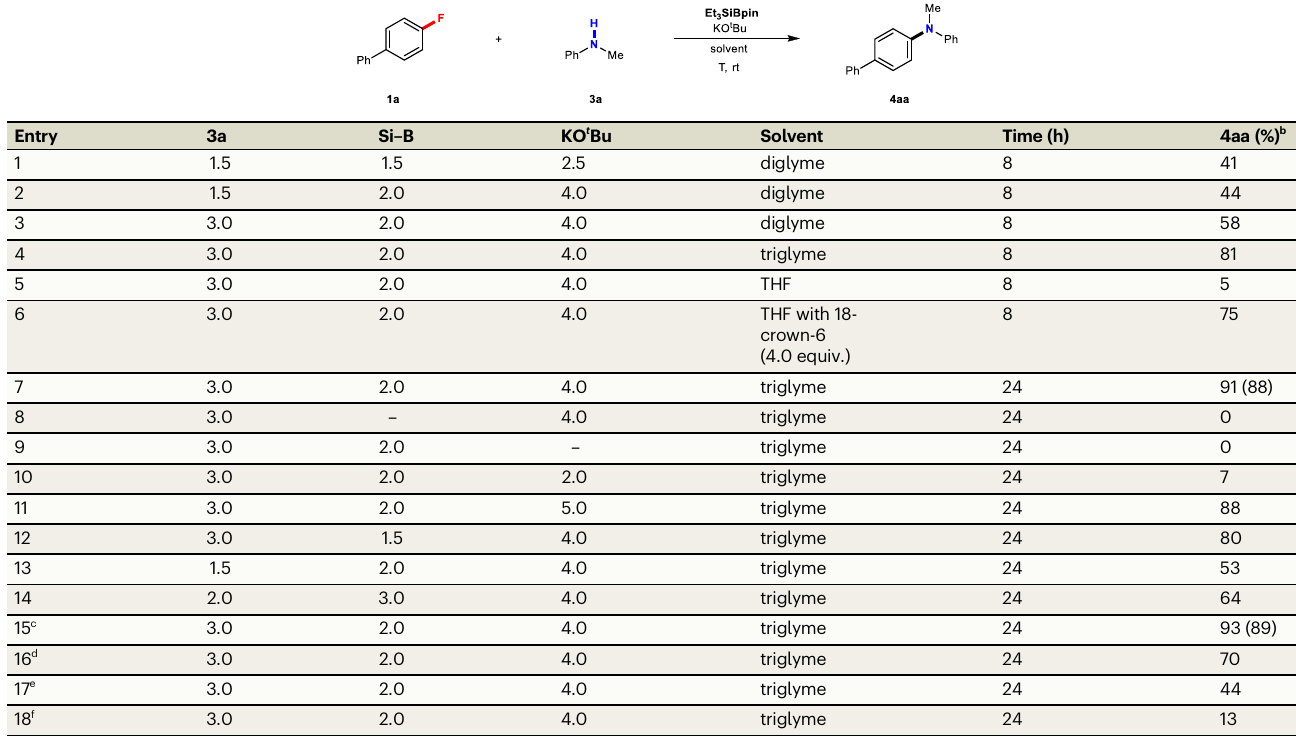
Table. 1 | Optimization of the de fl uoroamination conditions